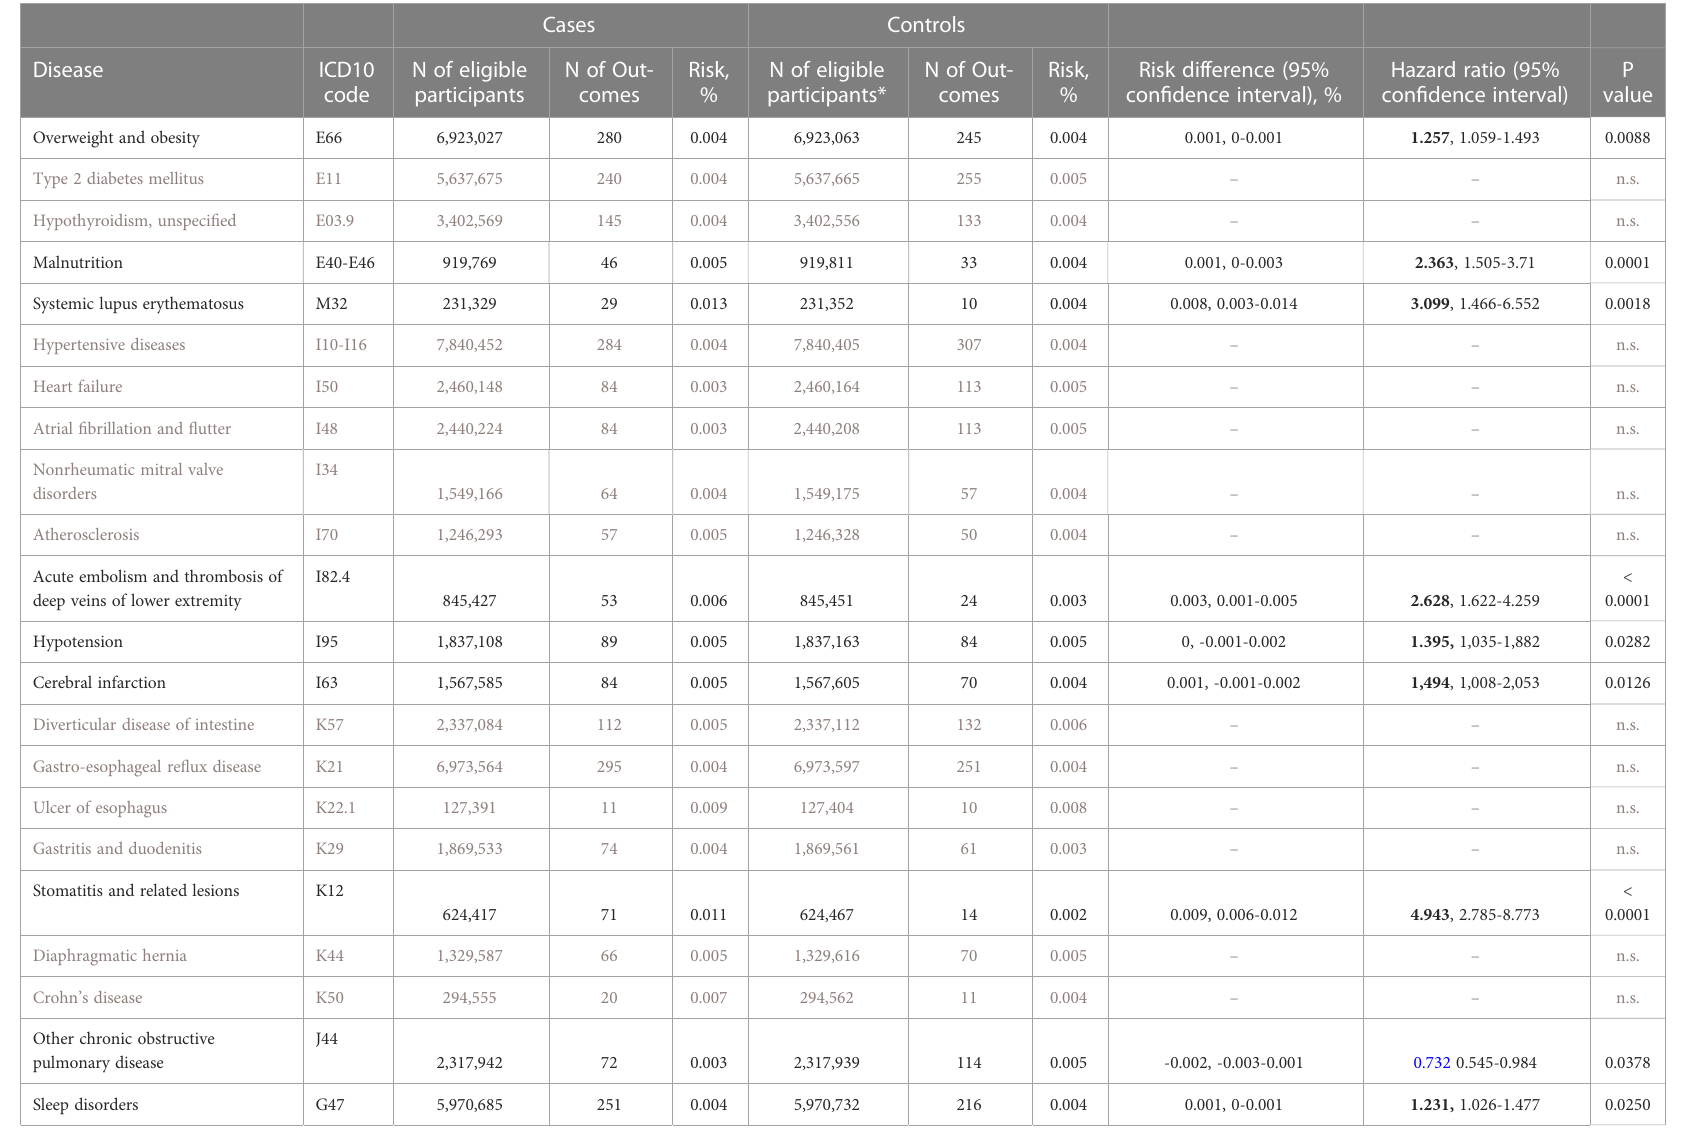
TABLE 1 Risk factors of epidermolysis bullosa acquisita